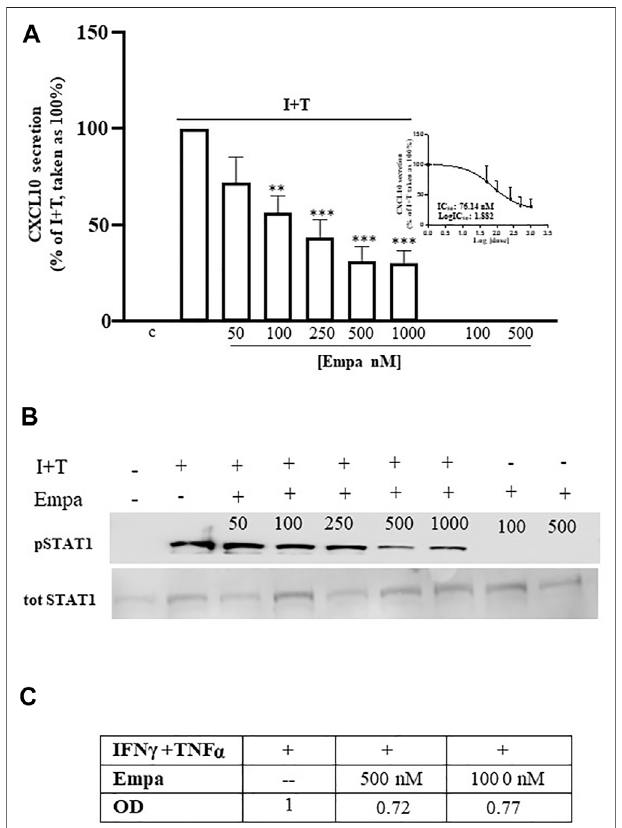
FIGURE 1 | Effect of Empa in human cardiomyocytes. (A) Treatment of Hfcm with Empa (50, 100, 250, 500, and 1,000 nM) inhibited CXCL10 secretion induced by I + T (1000U + 10 ng/ml) with a dose-dependent effect, statistically signi fi cant from 100 nM (44% inhibition, ** p < 0.01 vs. I + T-treated cells, taken as 100%); the maximal inhibitory effect was observed at 500 – 1,000 nM(69 – 70%inhibition*** p < 0.001vs.I+T-treatedcells,takenas 100%; # p < 0.05 vs. Empa 50 nM). The dose – response curve identi fi es a calculatedIC50=76.14 nM(insetof Figure1A ).Secretionassayswererunin quadruplicate in four different cell preparations ( n = 4); data were normalized vs. total protein amount and are expressed as percent of I + T-induced secretion (mean ± SE). CXCL10 secretion in control and in cells treated with Empa alone (500 – 1,000 nM) was undetectable. (B) Dose – response Western blot analysis showed that Empa 500 and 1,000 nM counteracted the cytokine-induced phosphorylation level of the IFN γ -dependent pathway Stat- 1. pStat-1 was not detected in control cells and with Empa alone (500 – 1,000 nM). The experiments were performed in three different preparations (n = 3); the picture depicts a representative blot. (C) Optical densitometric (OD) analysis of the IFN γ /TNF α -induced pStat-1 level with and without Empa 500 – 1,000 nM; data were normalized vs. total Stat-1 (tot Stat- 1) and are expressed as relative protein fold increase vs. cytokine-induced phosphorylation taken as 1.